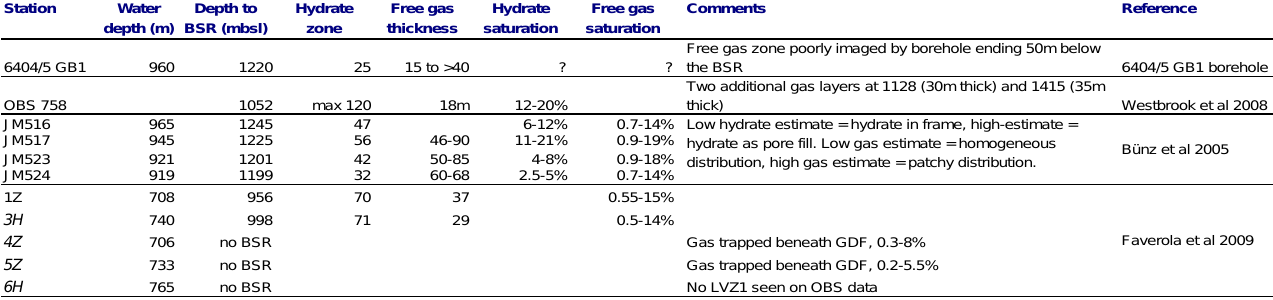
Table 2. Summary of the column height and saturation values derived from the 6404/5 GB1 borehole as well as the OBS sites of Bünz et al. [56], Westbrook et al. [58] and Faverola et al.